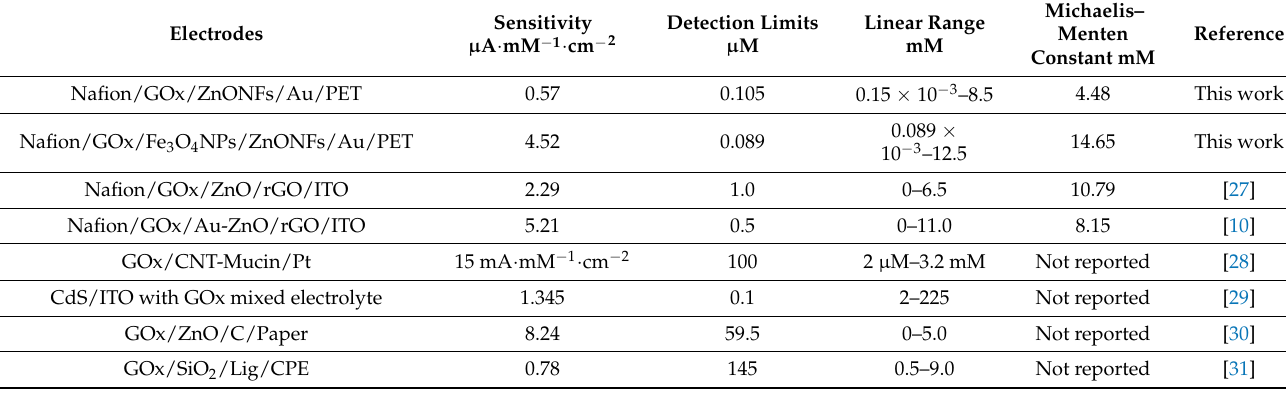
Table 1. Comparison of the performance of the enzyme glucose